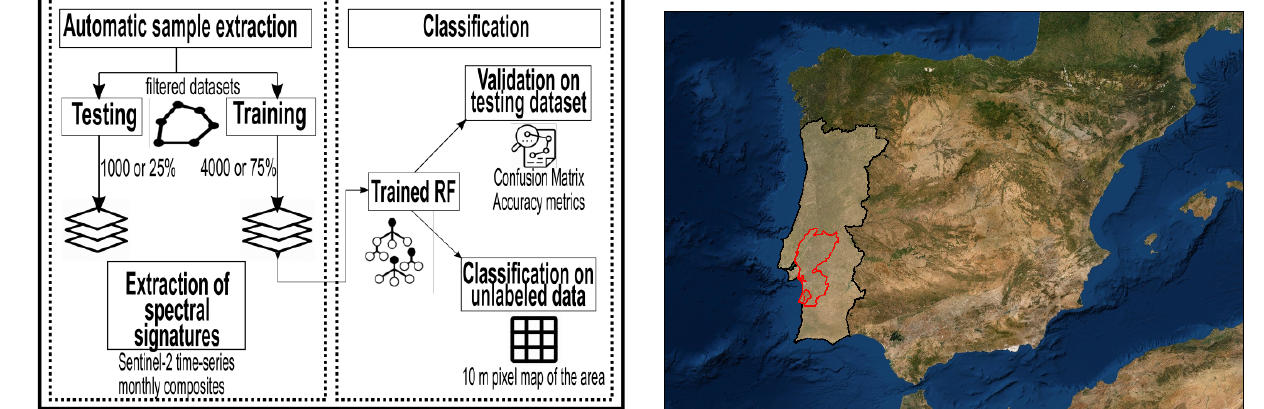
Figure 1. Flowchart for the automatic production of a land cover and crop type map